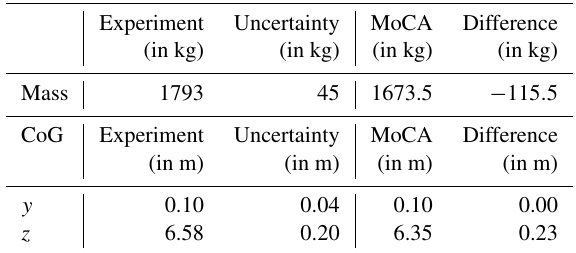
Table 1. Comparison of the total mass and the center of gravity